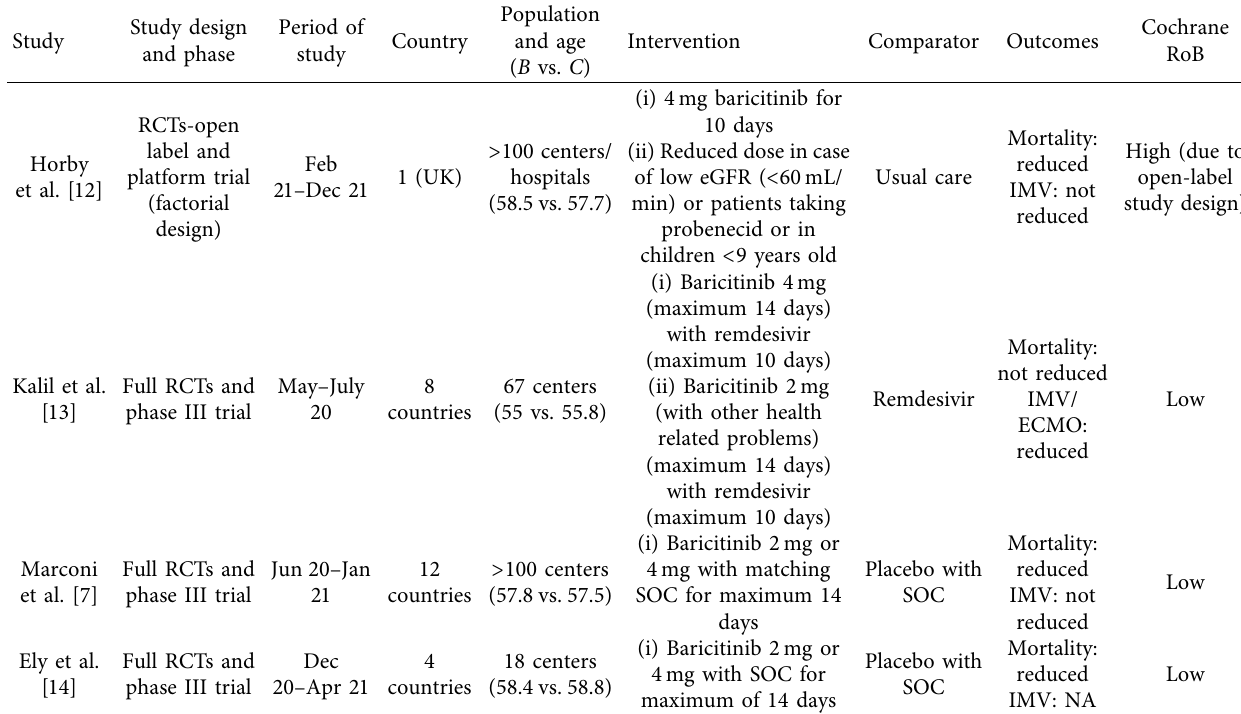
Figure 1: The flowchart detailing the systematic literature search. The chart was prepared using Review Manager 5.4.1 [8]. Table 1: Characteristics of the included articles and the